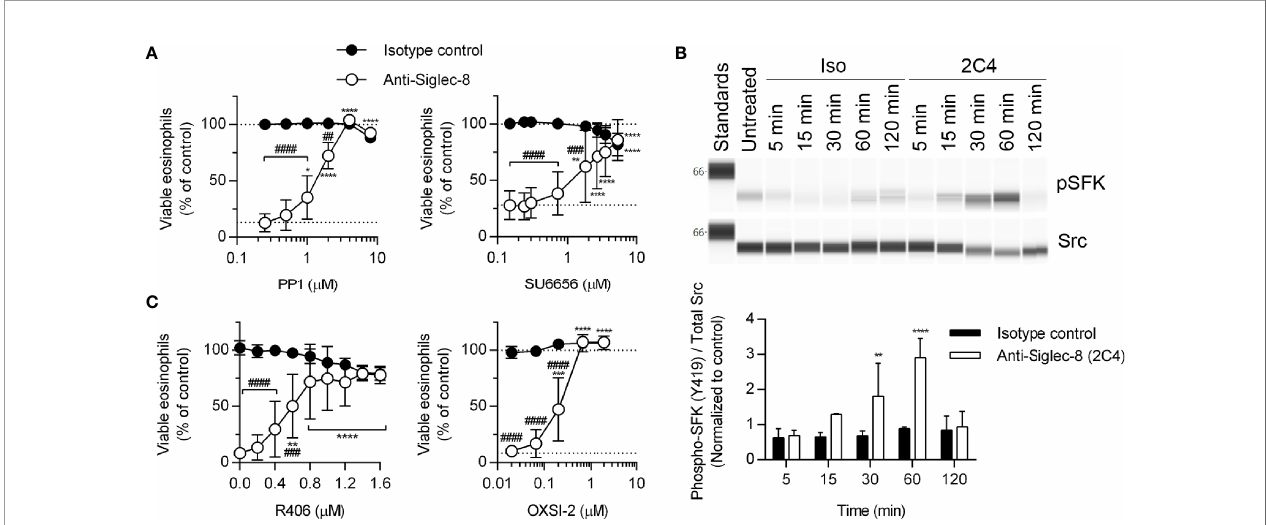
FIGURE 2 | SFKs and Syk are necessary components of the Siglec-8 signaling cascade. (A) Eosinophils were primed with IL-5 and pretreated with pharmacological inhibitors that act on SFKs (PP1, SU6656) at the indicated concentrations for 30 min prior to treatment with anti-Siglec-8 (open circles) or isotype control mAb ( fi lled circles) for 18 – 24 hr. Cell viability was then assessed by annexin V and DAPI staining by fl ow cytometry and normalized to that of untreated samples. Dotted lines indicate viability levels with no pharmacological inhibition. Data represent means ± standard deviations of 3 and 5 independent experiments, respectively. (B) Primed eosinophils were incubated with anti-Siglec-8 (2C4) or isotype control mAb (IgG1) for the indicated durations (in minutes) prior to lysis and the subsequent separation and detection of phospho-SFK (pY419) and total Src. Upper panel: representative western blot. Lower panel: quanti fi ed band intensities representing the means ± standard deviations of 4 independent experiments. Band intensities were normalized to those of untreated control samples. **p < 0.01, ****p < 0.0001 vs. isotype control samples at the same time point. (C) Primed eosinophils were pretreated with the Syk inhibitors R406 or OXSI-2 at the indicated concentrations for 30 min prior to treatment with anti-Siglec-8 (open circles) or isotype control mAb ( fi lled circles) for 18 – 24 hr. Cell viability was assessed as in (A) . Data represent means ± standard deviations of 3 independent experiments. (A, C) *p < 0.05, **p < 0.01, ***p < 0.001, ****p < 0.0001 relative to within – antibody stimulation group vehicle control sample. ## p < 0.01, ### p < 0.001, #### p < 0.0001 relative to isotype control sample at the same pharmacological inhibitor